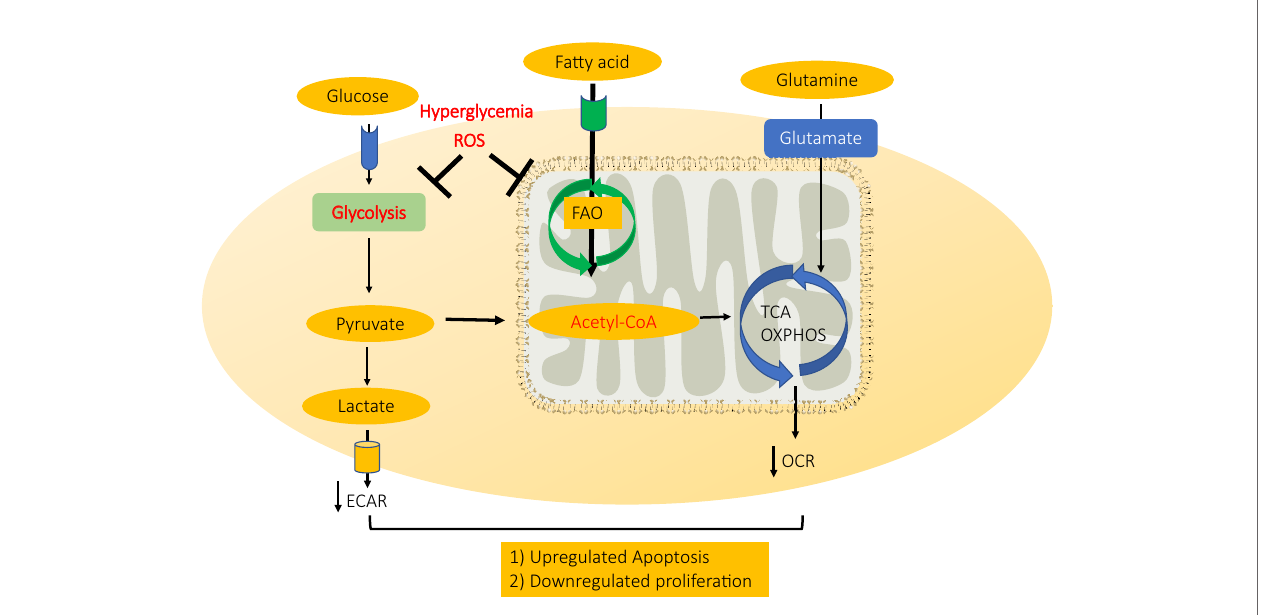
FIGURE 6 | A schematic model for mechanism CMEC dysfunction in diabetes. High glucose-induced ROS accumulation in diabetic cardiac microvascular endothelial cells disrupts normal ATP production by inhibiting both mitochondrial electron transport system and glycolysis, therefore inhibiting CMEC proliferation and inducing